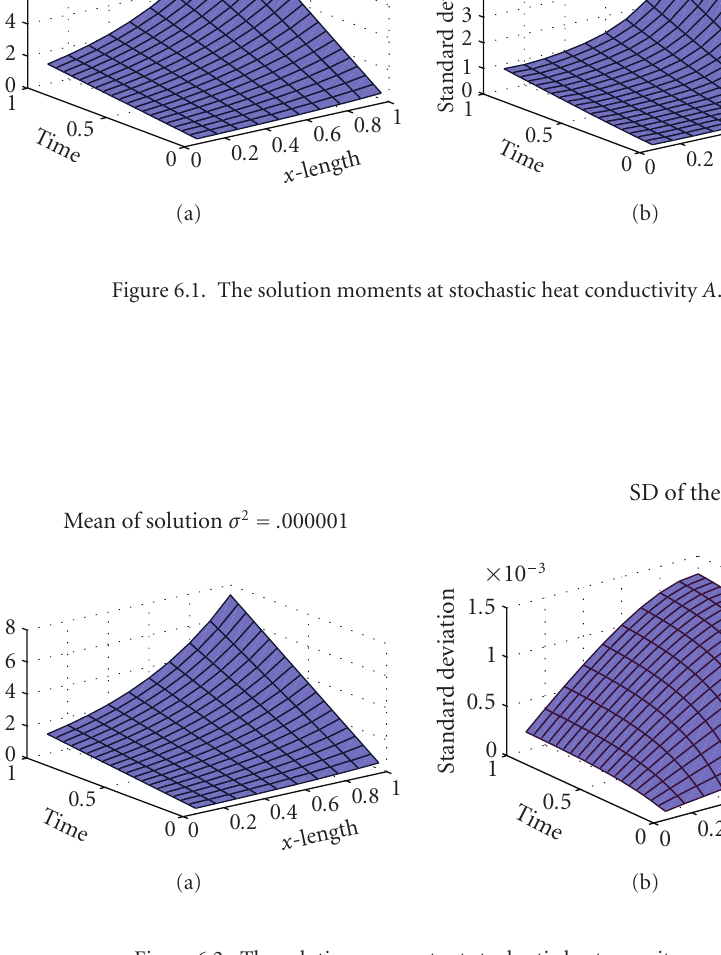
Figure 6.2. The solution moments at stochastic heat capacity c